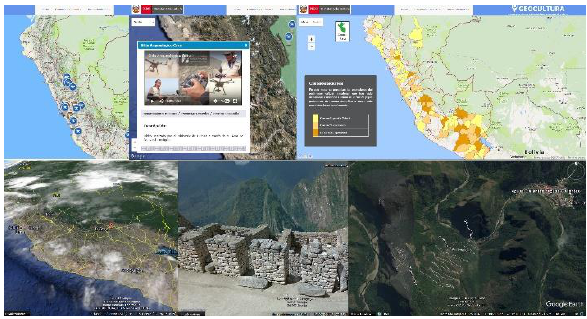
Figure 12. Geographic situation of the Andean Road System and Drones flight and Virtual Tour in Peru. © Sistema de Información Geográfica- Geocultura; Google Maps and Google Earth and Arches Project. Images: Screen capture, 2017.